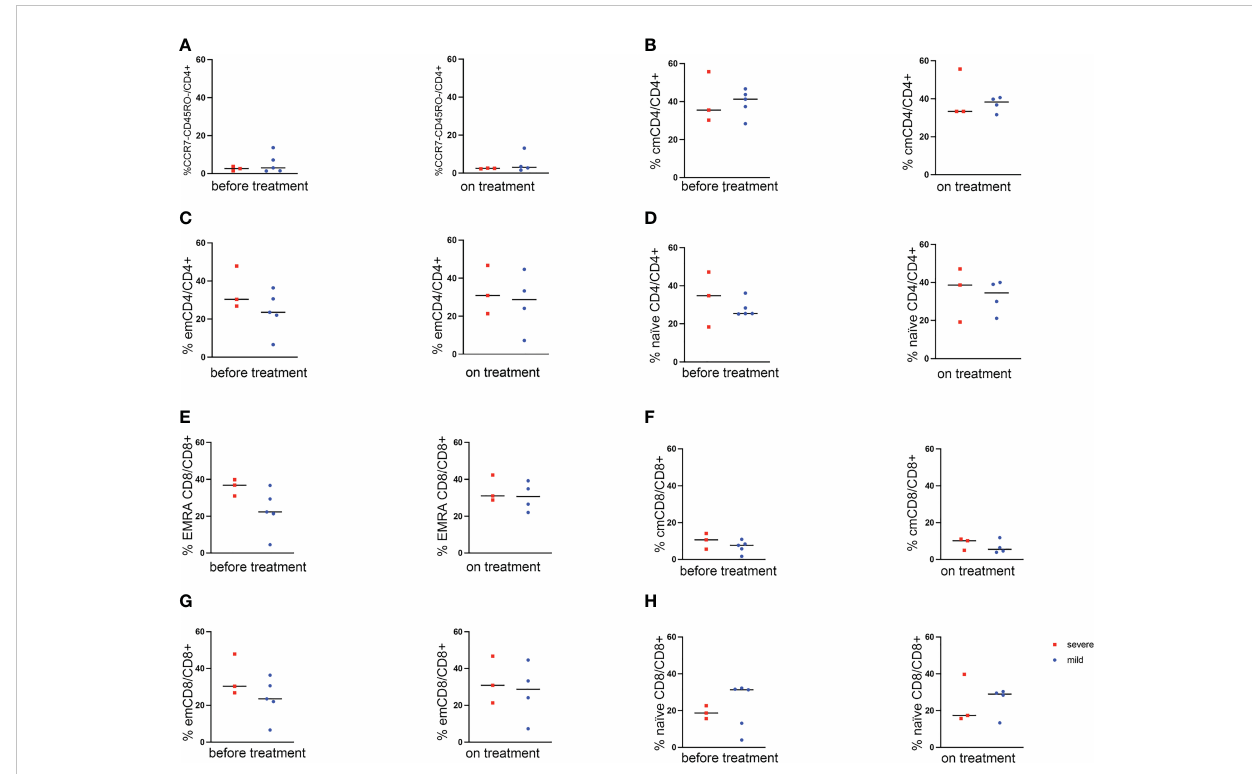
FIGURE 2 Analysis of lymphocyte subpopulations in patients treated with PD-1 monoblockade. Comparison of mean percentage of subpopulations of lymphocytes between the two patient groups of cohort 1 (severe vs mild) before the treatment and on the treatment. (A – D) CD4 + T cell subpopulations: (A) CD4 + CCR7 - CD45RO - cells. (C) effector memory (em, CD4 + CCR7 - CD45RO + cells). (B) central memory (cm, CD4 + CCR7 + CD45RO + cells). (C) effector memory (em, CD4 + CCR7 - CD45RO + cells). (D) naïve (CD4 + CCR7 + CD45RO - cells). (E – H) CD8 + T cell subpopulations: